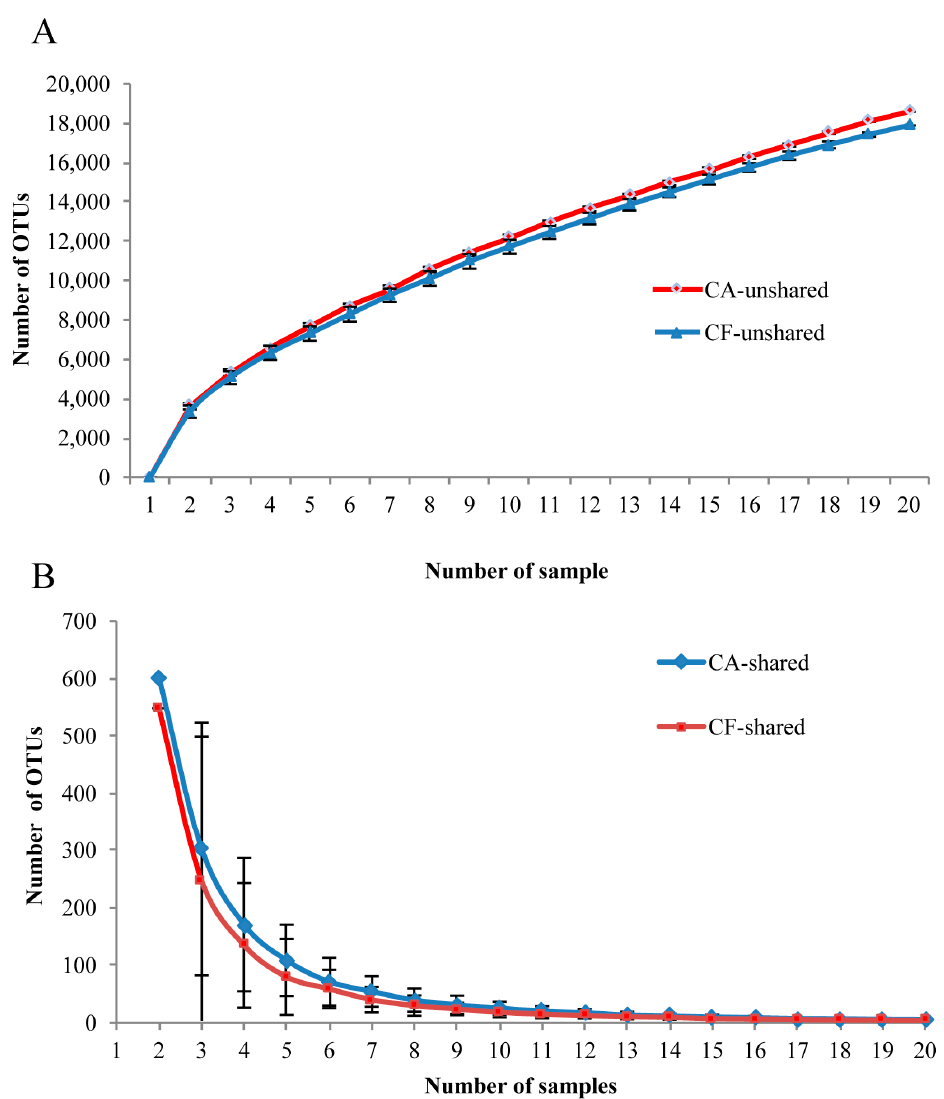
Figure 4. Curves of shared and unshared OTUs (mean ± SD) among children in the caries-affected (CA) and caries-free (CF) groups. ( A ) Unshared OTUs among children in the CA and CF groups; ( B ) Shared OTUs among children in the CA and CF groups.